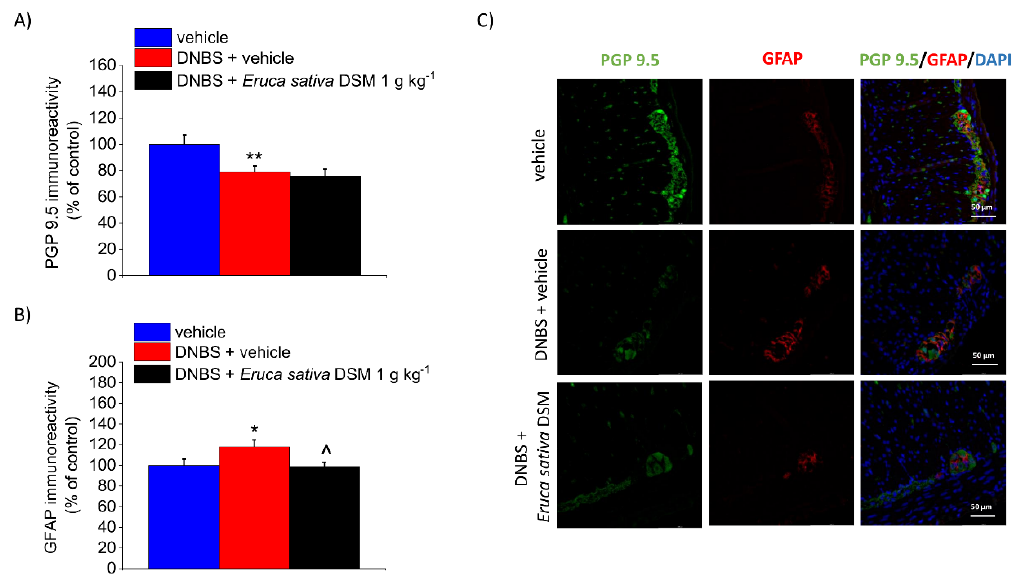
Figure 7. The effect of the repeated treatment with Eruca sativa DSM on neuronal damage and glia activation within the colonic myenteric plexus of DNBS rats. Eruca sativa DSM (1 g kg − 1 ) was administered once daily in the DNBS-treated animals, starting from the day of DNBS injection for 14 consecutive days, then tissues were collected. Immunolabeling quantification of PGP 9.5 ( A ) and GFAP ( B ) with relative immunofluorescence images showing the expression of PGP 9.5 (green), GFAP (red), and DAPI (blue) in the myenteric plexus of the colon ( C ). Quantitative analysis of PGP9.5- and GFAP-related immunofluorescence intensity (arbitrary unit) was performed by collecting independent fields (4–6 for each animal) from the myenteric plexi. Results were expressed as a percentage of the control group (vehicle-treated animals). Each value represents the mean ± SEM of six animals per group. * p < 0.05 vs. vehicle. ** p < 0.01 vs. vehicle. ^ p < 0.05 vs. DNBS. Original magnification: 40×.